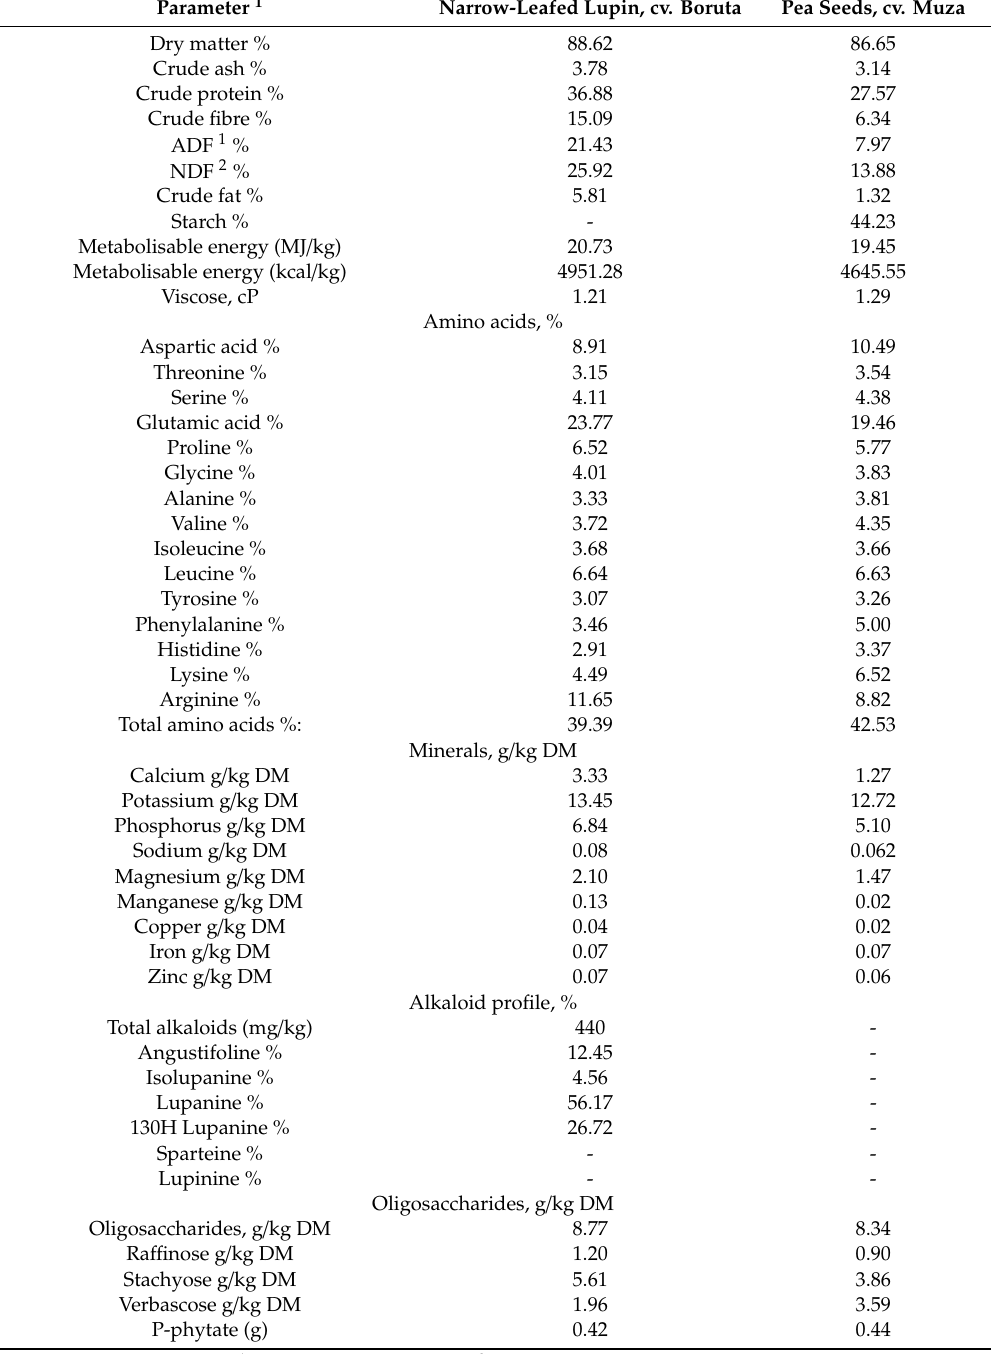
Table 2. Chemical composition of narrow-leafed lupin seeds (cv. Boruta) and pea seeds (cv.